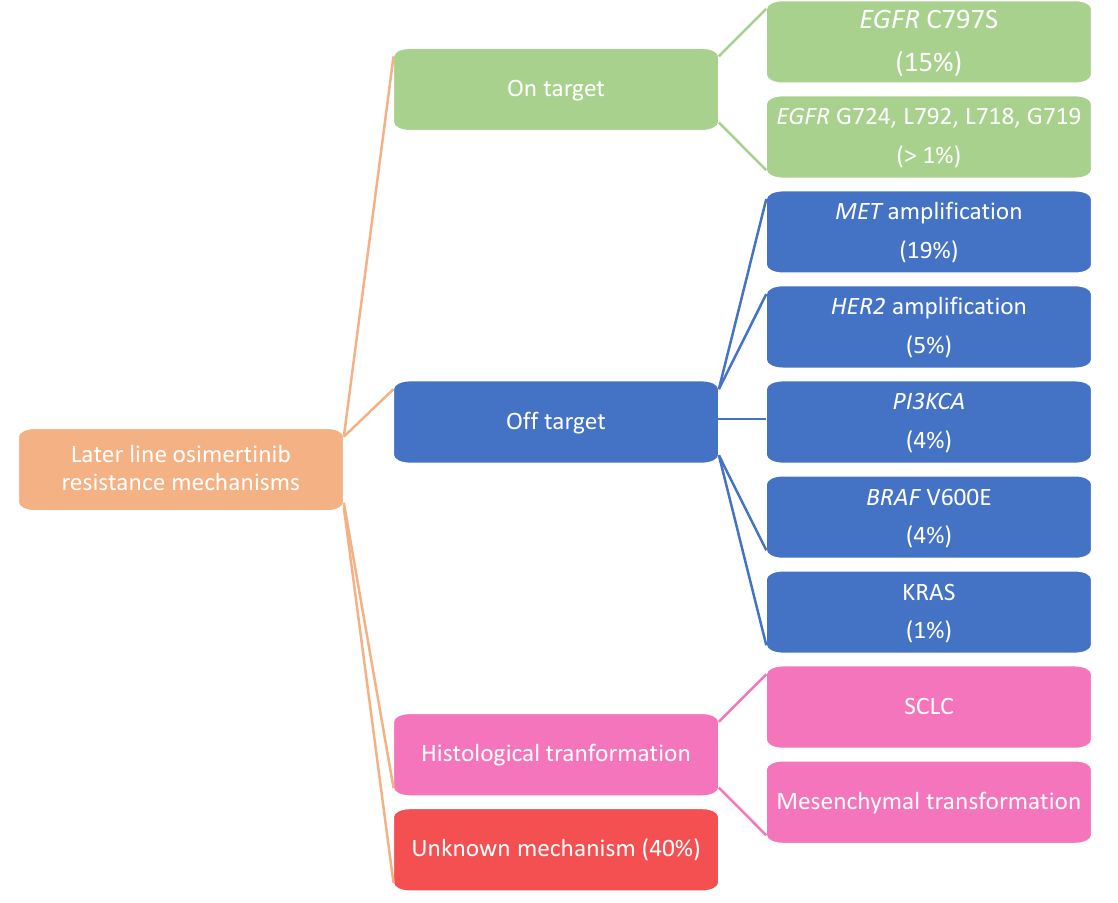
Figure 2. Mechanisms of acquired resistance to first-line